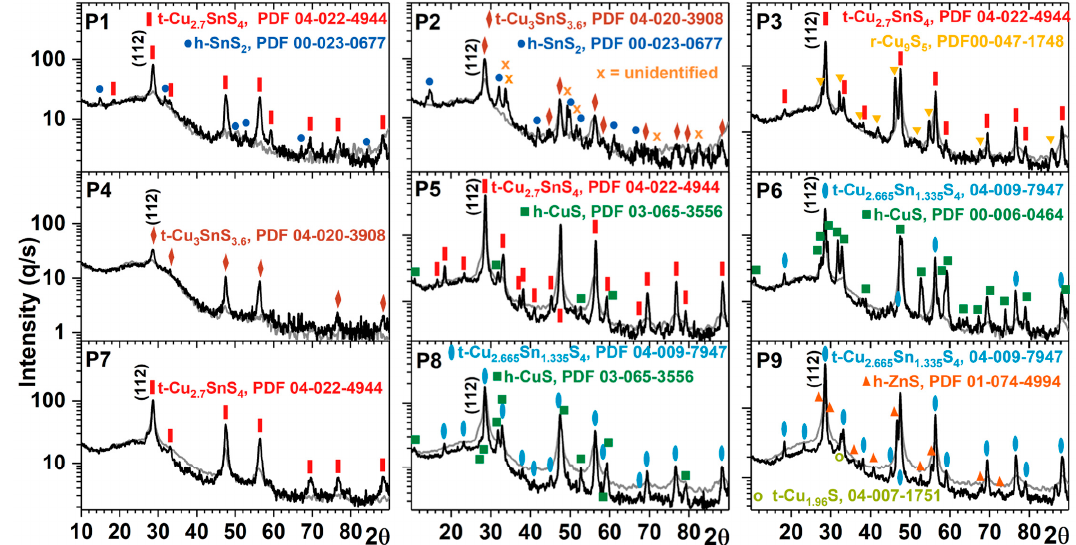
Figure 2. X-ray di ff raction patterns of the nine Cu 2 S–ZnS–SnS 2 thin films in the as-deposited state (gray curves) and after sulfurization annealing at 450 ◦ C for one hour (black curves). The assignment of phases and orientations was done using the International Centre for Di ff raction Data (ICDD) database (see Table 3). h = hexagonal; t = tetragonal; r = rhombohedral. The Powder Di ff raction File (PDF) for each crystalline phase is also